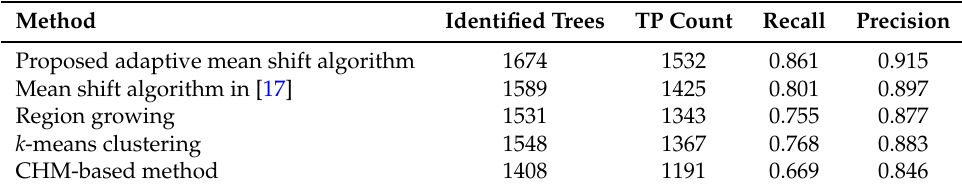
Table 5. Comparison of overall detection performance among different